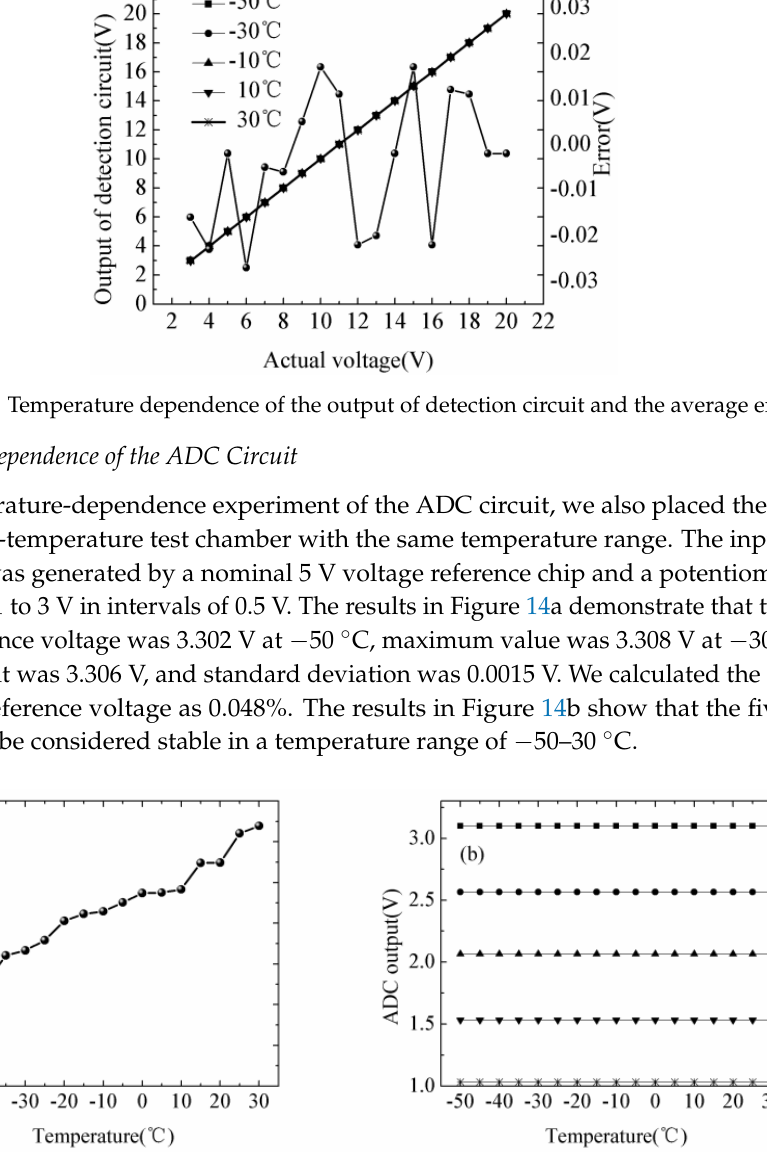
Figure 14. Temperature dependence of the ( a ) reference voltage, and ( b ) output of the ADC circuit (the measured and ideal voltage values of 1, 1.5, 2, 2.5, and 3 V).